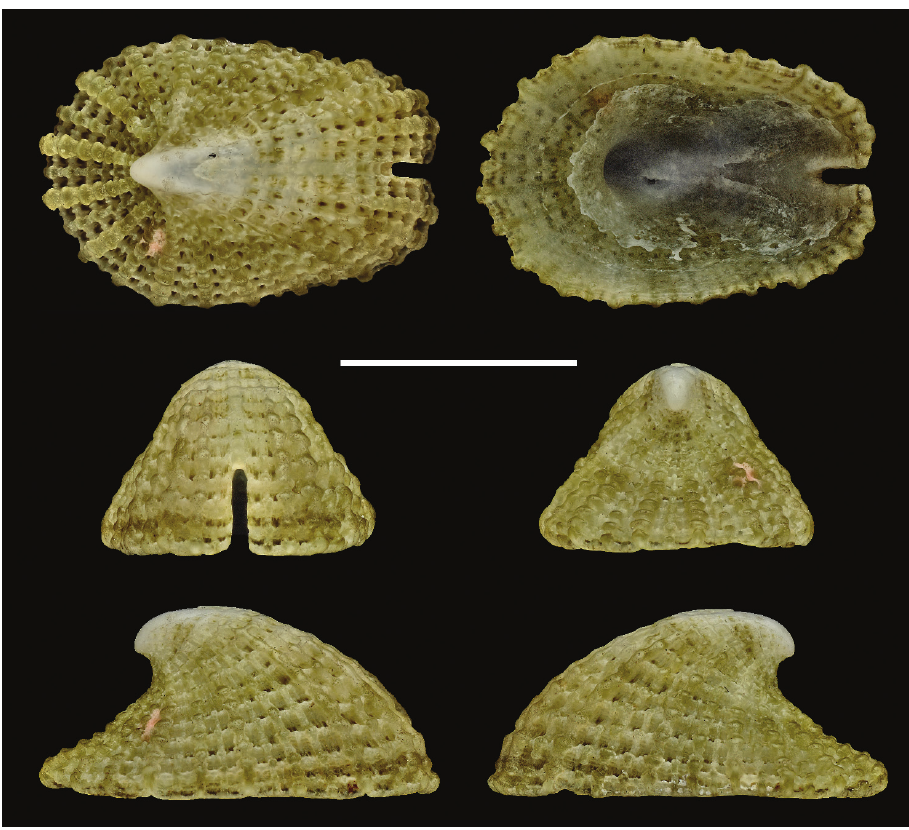
Figure 9. Emarginula thorektes Kilburn, 1978. Holotype T2193/NMSA-MOL 0A3829. Scale bar: 5